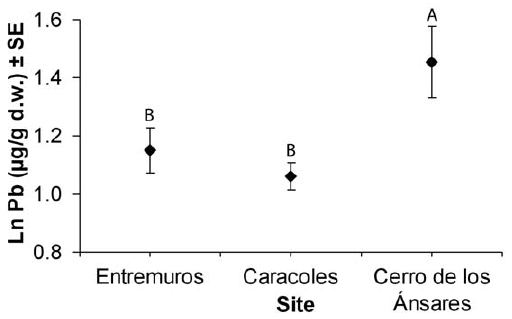
Figure 2. Estimated marginal means( ± SE) of fecal Pb concen- trations for greylag geese by sampling site as obtained in a GLM model when considering Al as a covariable. Means sharing a capital letter did not differ significantly (LSD, p . 0.05).